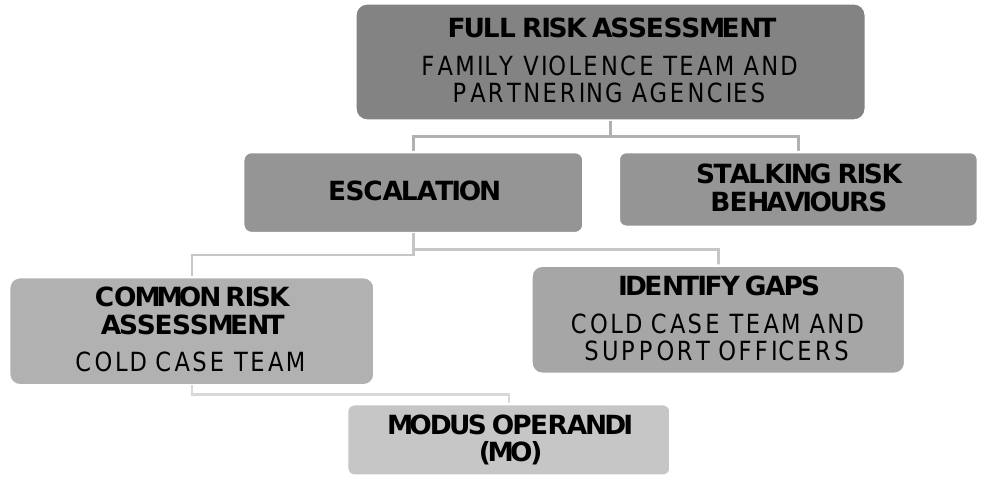
Figure 3: Stages of cyberstalking risk